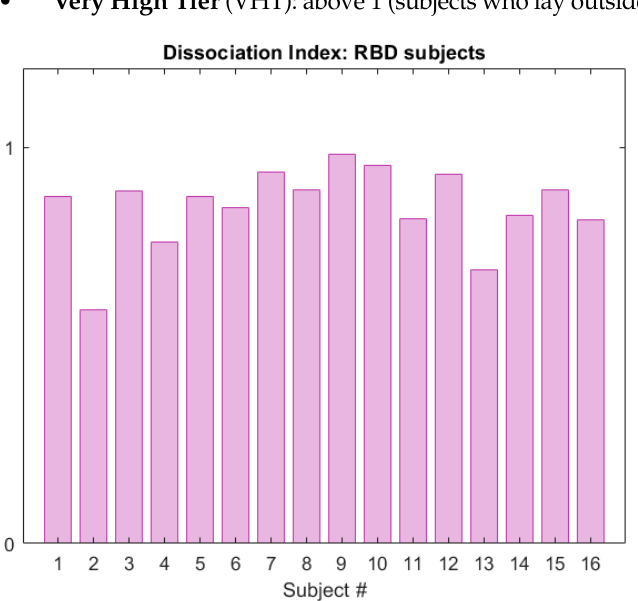
Figure 11. Dissociation Index computed on the RBD subjects (CAP Sleep Database), within neigh- bourhood R 2 of reference S 2 .